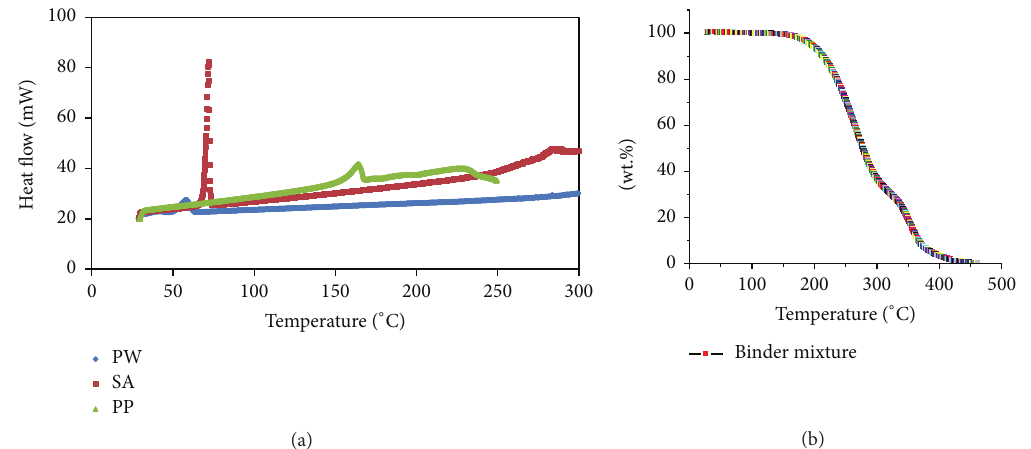
Figure 2: Binder components. (a) DSC analysis, (b) TGA analysis.